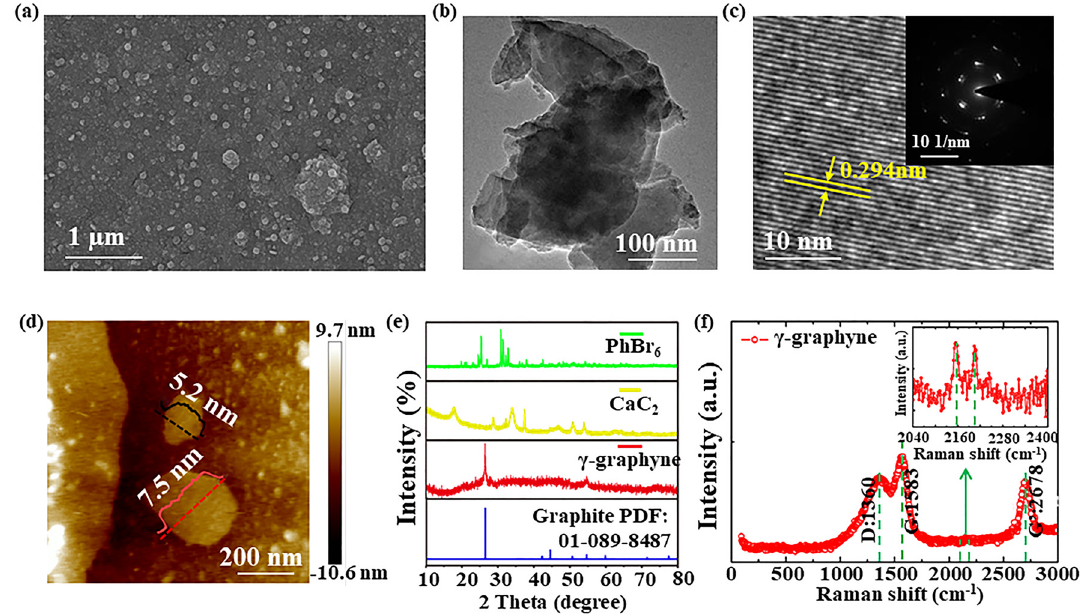
Figure 3: (a) scanning electron microscopy (SEM) image, (b) transmission electron microscopy (TEM) image, (c) high-resolution transmission electron microscopy (HRTEM) image of exfoliated graphdiyne (inset is SEAD pattern), (d) atomic force microscope (AFM) image relative cross- sectional analysis of as-prepared graphdiyne nanosheets, (e) X-ray diffraction (XRD) pattern of as-prepared graphdiyne nanosheets and (f) Raman spectra of exfoliated graphdiyne nanosheets on SiO 2 /Si